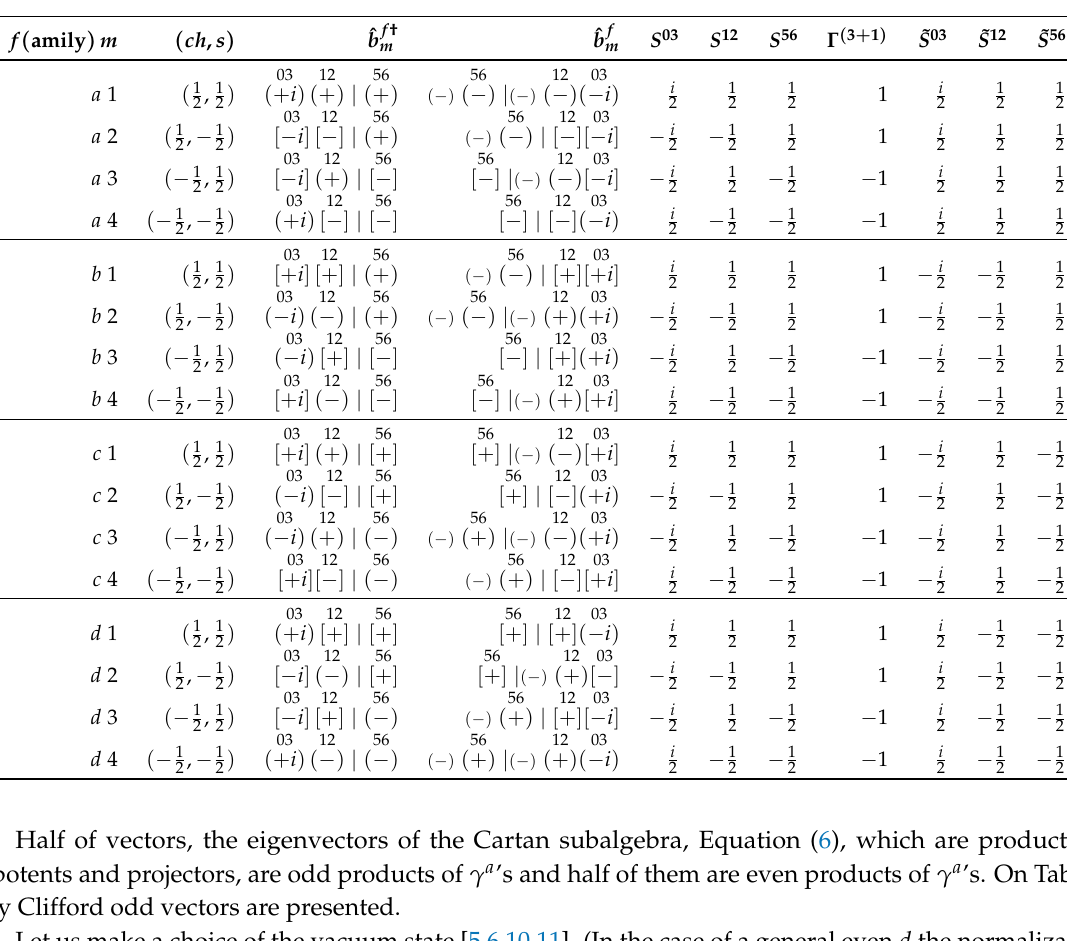
Table 1. The basis creation operators ˆ b f † m , which are sums of odd products of γ a ’s, and their annihilation partners ˆ b f m are presented for the d = ( 5 + 1 ) -dimensional case. Here m = ( ch , s ) , ch represents the spin in d = ( 5,6 ) , manifesting in d = ( 3 + 1 ) the charge, and s represents the spin, that is the eigenvalue of S 12 , according to the choice of the Cartan subalgebra, Equation (6). The basis creation operators are the products of nilpotents and projectors, which are the “eigenstates” of the Cartan subalgebra generators, ( S 03 , S 12 , S 56 ) and ( ˜ S 03 , ˜ S 12 , ˜ S 56 ), presented in Equation